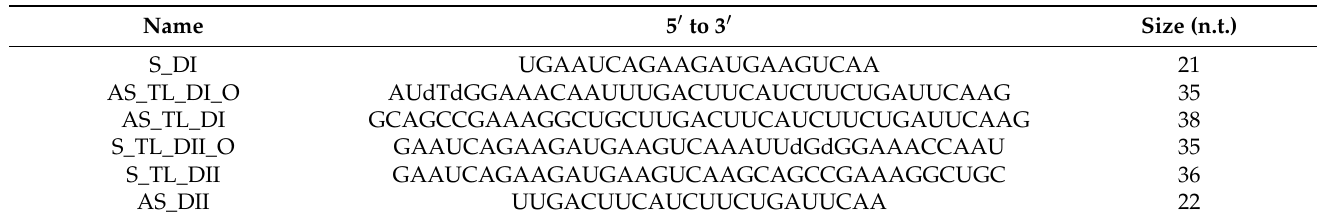
Table 1. The sequence of each strand of DsiRNAs. DsiRNA sequences were used to synthesize the tetra-looped DsiRNAs. n.t.; nucleotide.